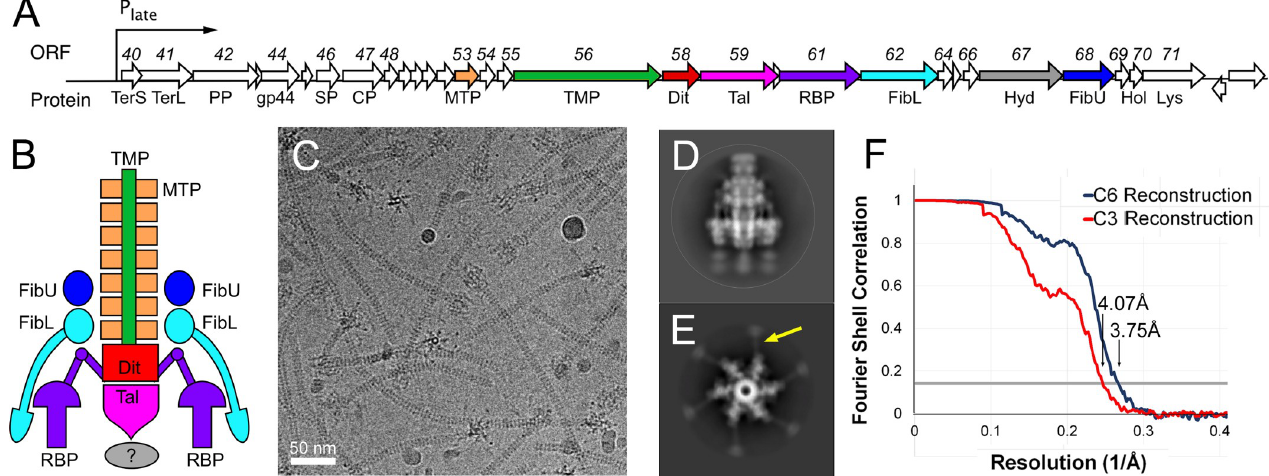
Fig 1. The 80 α baseplate. (A) Schematic diagram of the late operon of bacteriophage 80 α . ORFs (arrows) corresponding to tail and baseplate proteins are colored tan (MTP), green (TMP), red (Dit), pink (Tal), purple (RBP), light blue (FibL), gray (Hyd), and dark blue (FibU). TerS, small terminase; TerL, large terminase; PP, portal protein; gp44, ejection protein; SP, scaffolding protein; CP, capsid protein; Hol, holin; Lys, lysin. (B) Schematic diagram of the baseplate, colored as in A. The question mark indicates an observed density of uncertain identity, probably corresponding to the Tal CTD. (C) Cryo-electron micrograph of 80 α tails collected on a Titan Krios microscope with a DE-20 detector. Scale bar = 50 nm. (D, E) 2D class averages, showing the baseplate in side (D) and top (E) views, viewed parallel and perpendicular to the long axis of the tail, respectively. A thin fiber is indicated with a yellow arrow in E. (F) Fourier shell correlation (FSC) curve between two half datasets for the C6 (blue) and C3 (red) reconstructions. The resolution at FSC = 0.143 (gray line) is indicated for each.